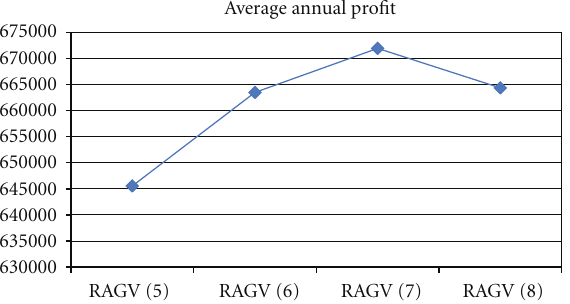
Figure 3: The results of simulation for di ff erent fleet sizes.